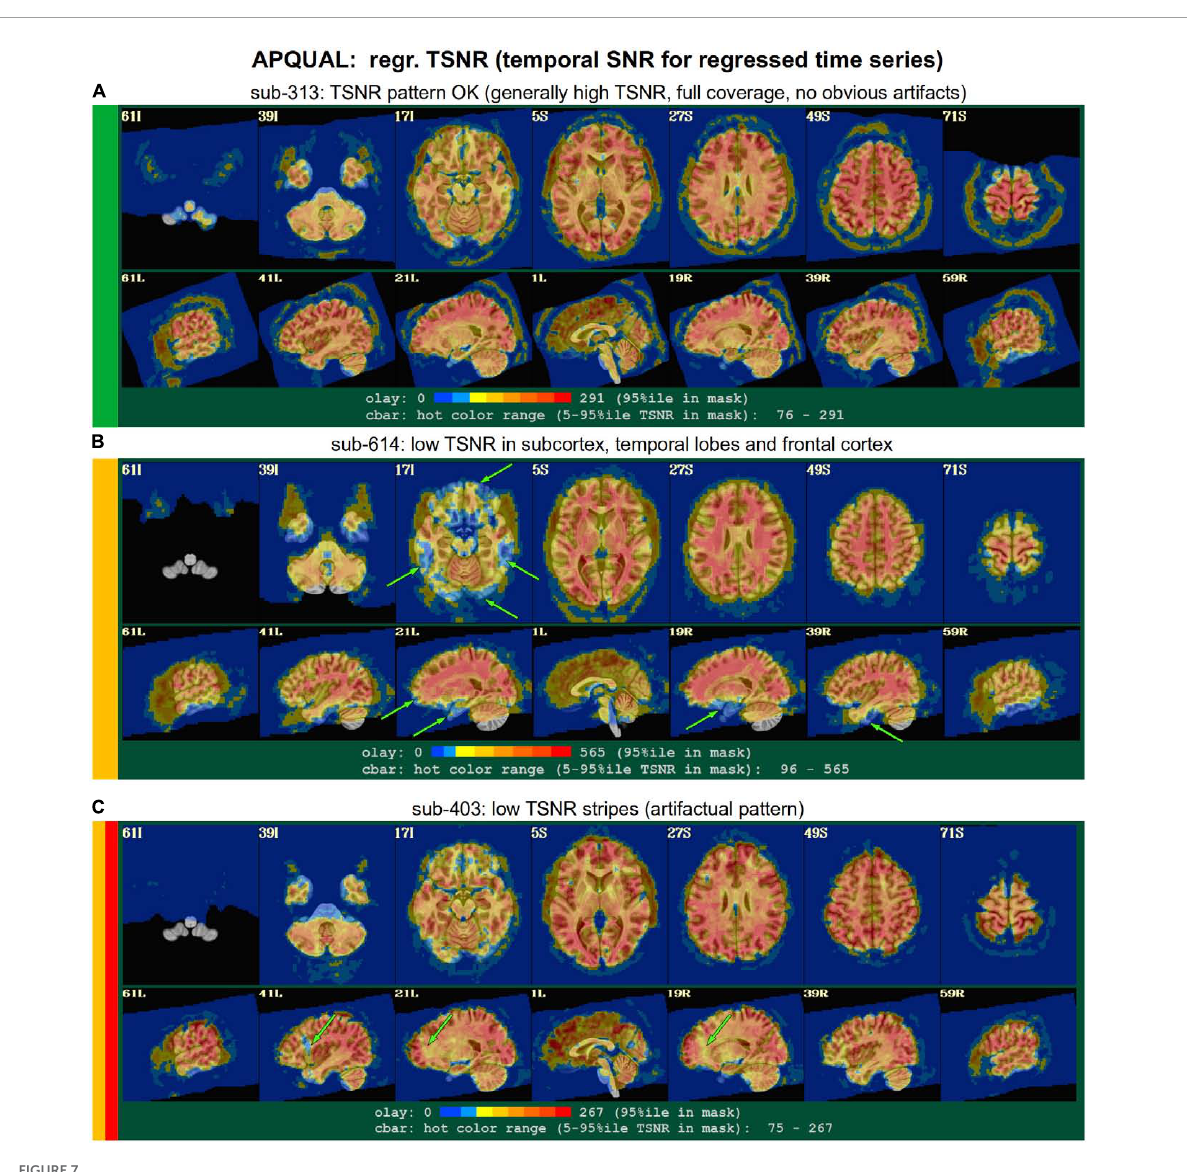
FIGURE7 APQUAL examples for the “regr” QC block: TSNR maps of the final data after regression modeling (for each voxel, TSNR is the mean of the modeled time series divided by the standard deviation of the residuals). (A) TSNR is relatively constant and high throughout the brain volume (only very small regions of low signal, in the anterior temporal lobes). (B) Large regions of low-TSNR, particularly in the subcortex and orbitofrontal regions, which may impact cortical results. (C) Vertical strips of low TSNR are present, which may affect connectivity analyses (and which, after GUI-based investigation with InstaCorr, appear to be due to a significant artifact, shown in Figure 10 , leading to subject exclusion; hence, the inclusion of red in the colorband to the left of the